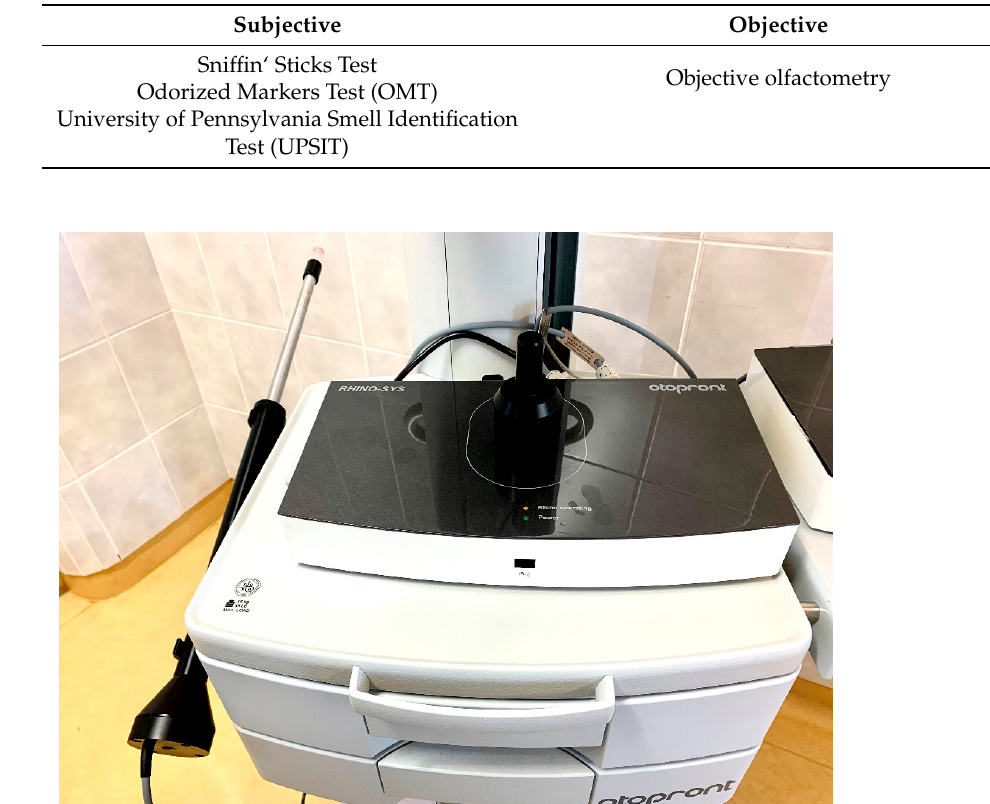
Figure 5. Rhinomanometry Otopront Rhino-sys (from co-author’s archive). Table 3. Olfactory assessment methods.